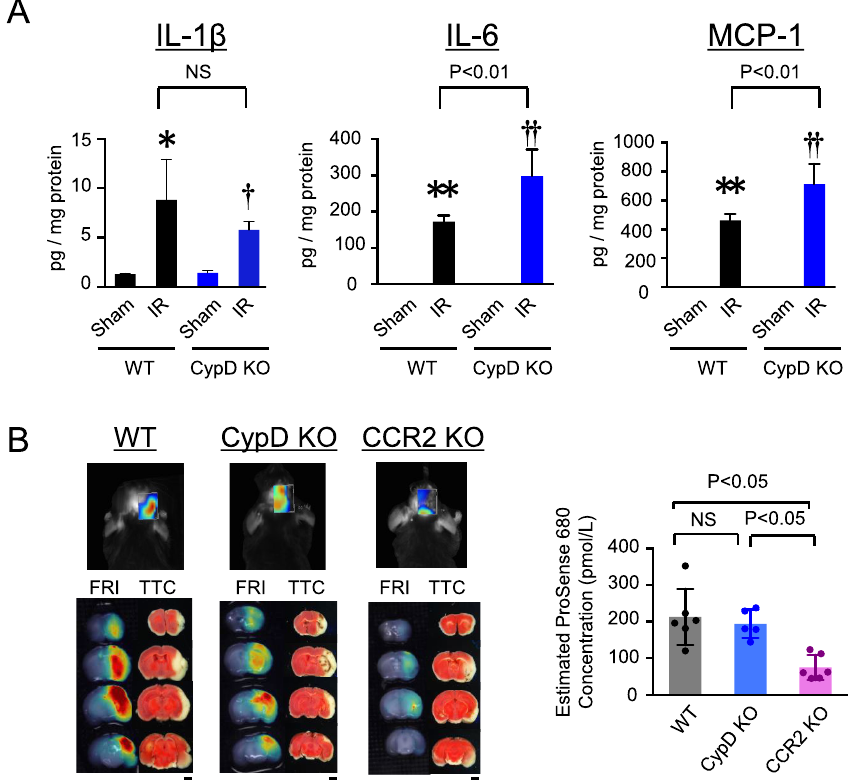
Figure 3. Depletion of CypD did not inhibit inflammation after cerebral IR injury. ( A ) Protein level of inflammatory cytokines in homogenized cerebral tissues at 24 h after reperfusion. Data are presented as the mean ± SD (N = 4 mice per sham group, N = 8 mice per IR group). * P < 0.01 versus sham in WT mice, ** P < 0.001 versus sham in WT mice, † P < 0.05 versus sham in CypD-KO mice, †† P < 0.001 versus sham in CypD-KO mice. Statistical analyses were performed by two-way ANOVA with Bonferroni’s multiple comparison tests. ( B ) Representative FMT (above) and FRI (below) images demonstrating protease activities at 72 h after IR visualized by ProSense 680. The graph indicates ProSense 680 concentrations in the cerebral tissues as estimated from the fluorescent intensity. The data represent the mean ± SD (N = 5–6 mice per group), and they were analyzed by one-way ANOVA followed by Bonferroni’s multiple comparison tests. FMT: fluorescence molecular tomography. FRI: fluorescence reflectance